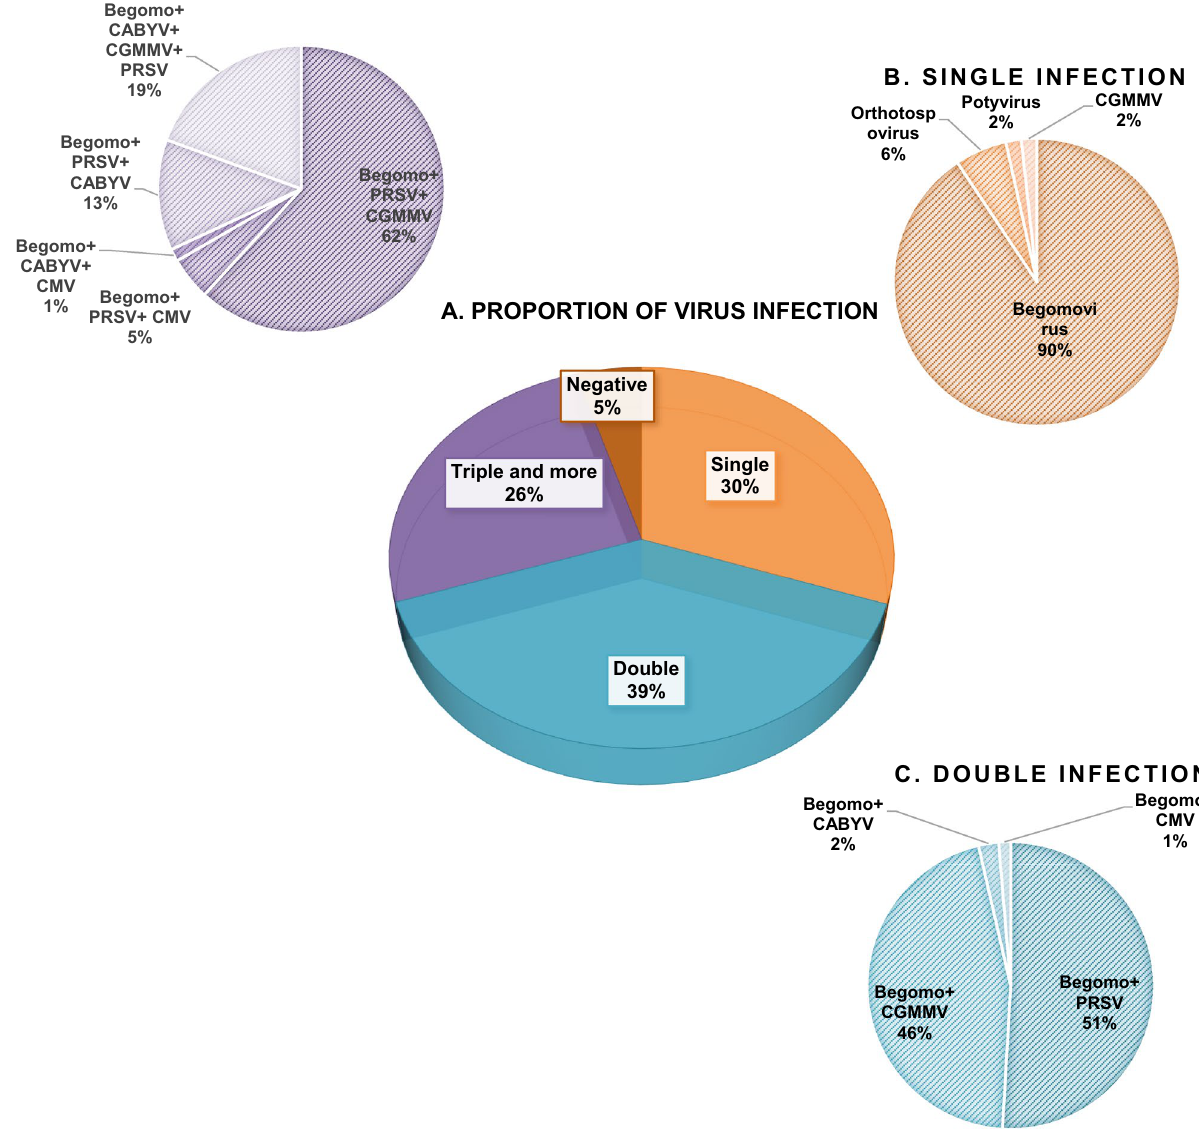
Figure 4. Status of mixed virus infection in cucurbits